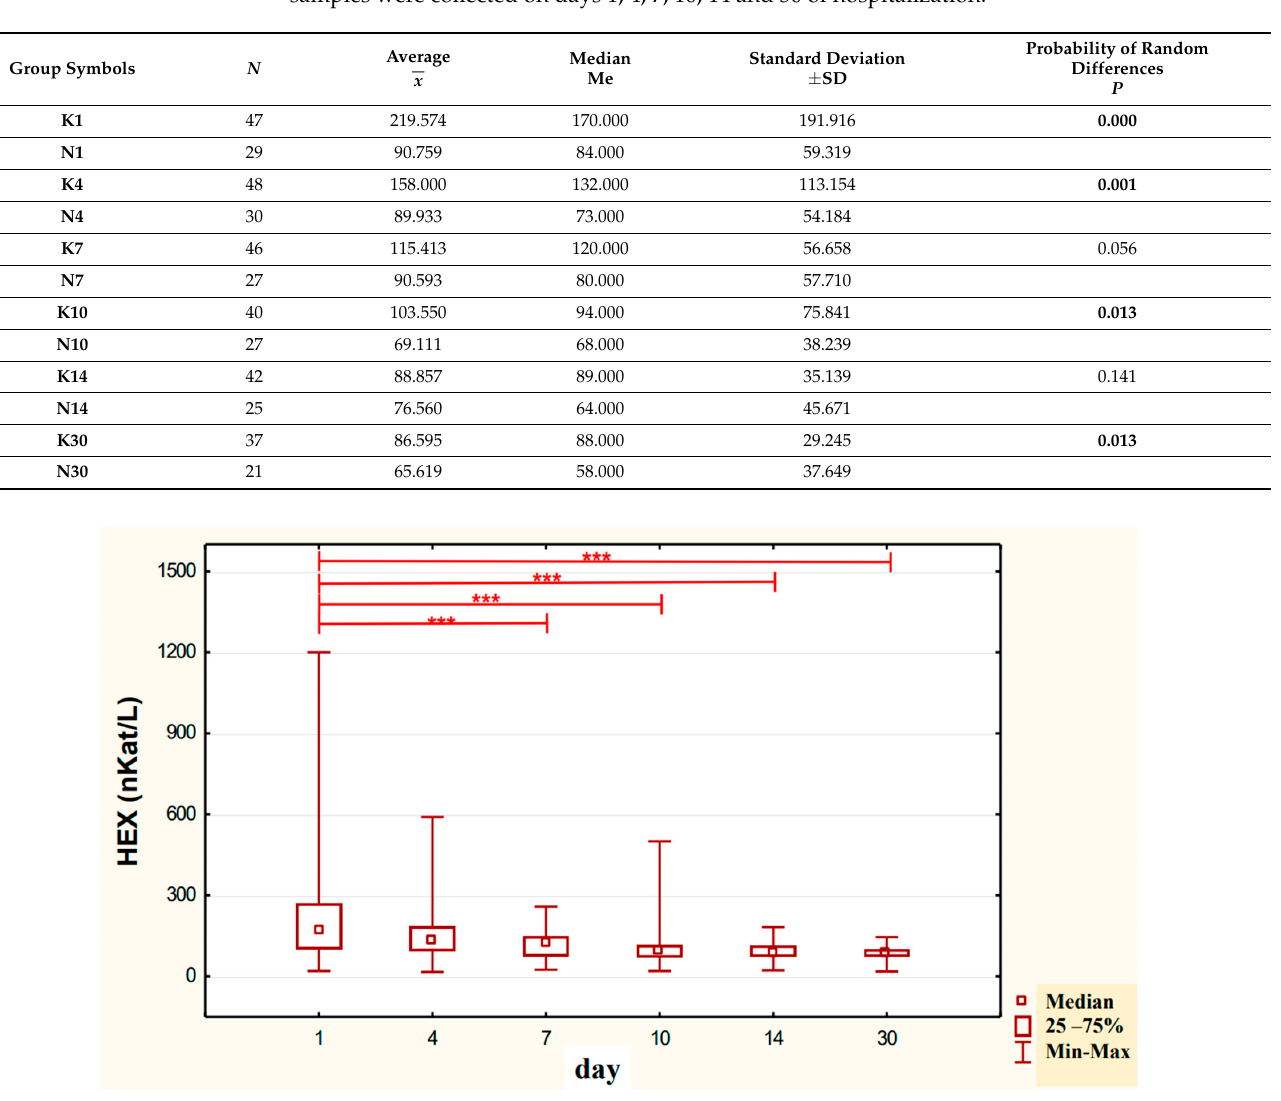
Table 2. The concentration of urinary HEX activity (nKat/L) in alcohol-dependent patients treated with neoglandin (N1–N30) and the control group not treated with neoglandin (K1–K30). Urine samples were collected on days 1, 4, 7, 10, 14 and 30 of hospitalization.